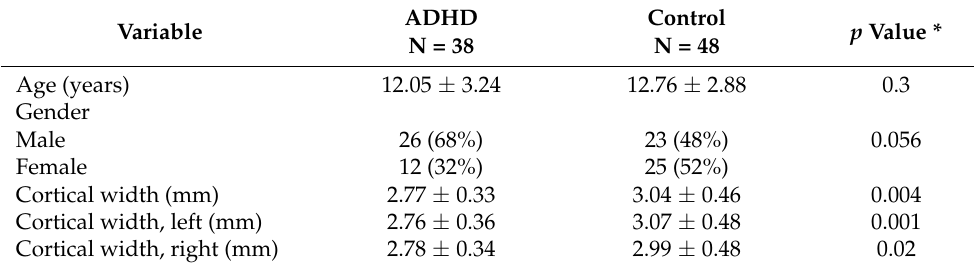
Table 1. Patient’s demographic and clinical